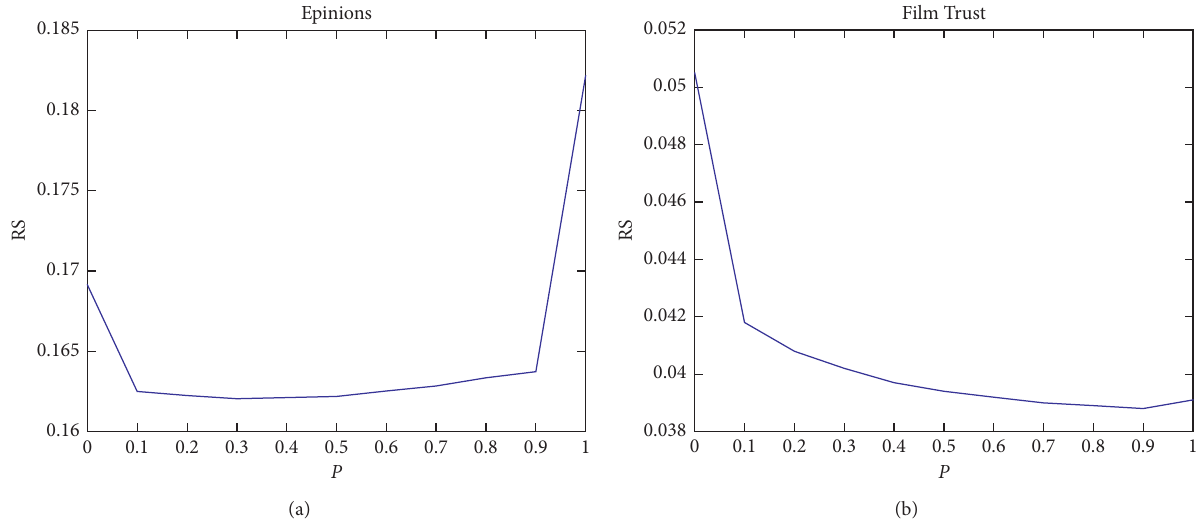
Figure 5: The simulation results of SMD1. (a) Epinions dataset. (b) FilmTrust dataset.